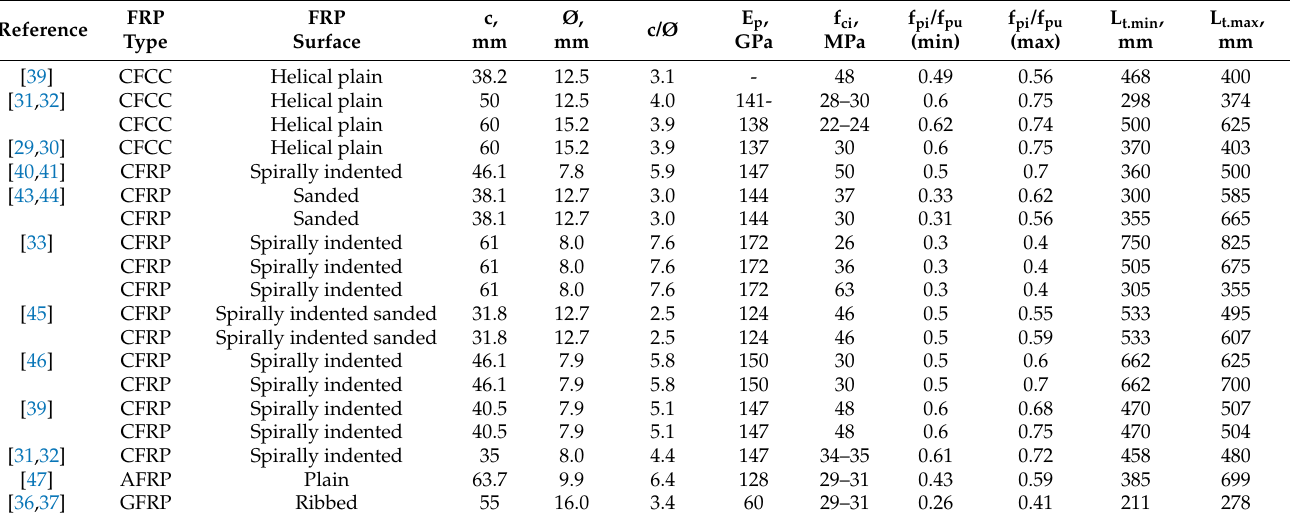
Table 3. Summary of transfer length results for the influence of prestress level of FRP reinforcement.